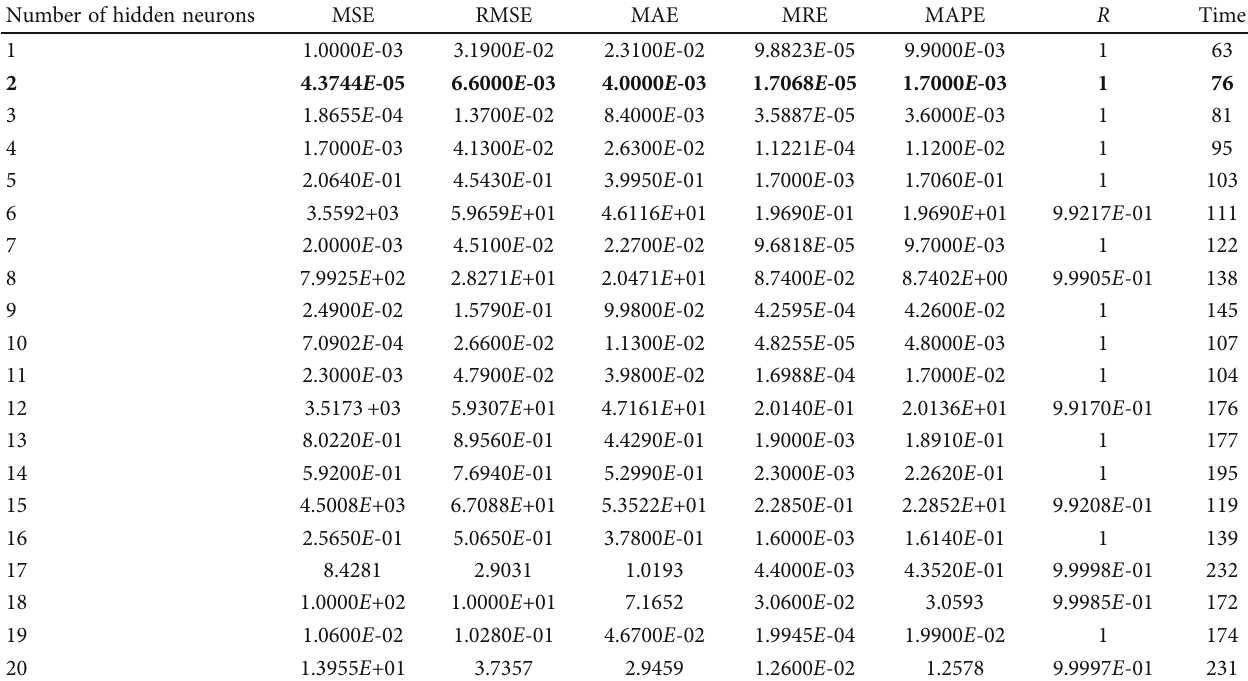
Table 7: Six inputs multilayer perceptron neural network performance analyses with di ff erent numbers of hidden neurons. Number of hidden neurons